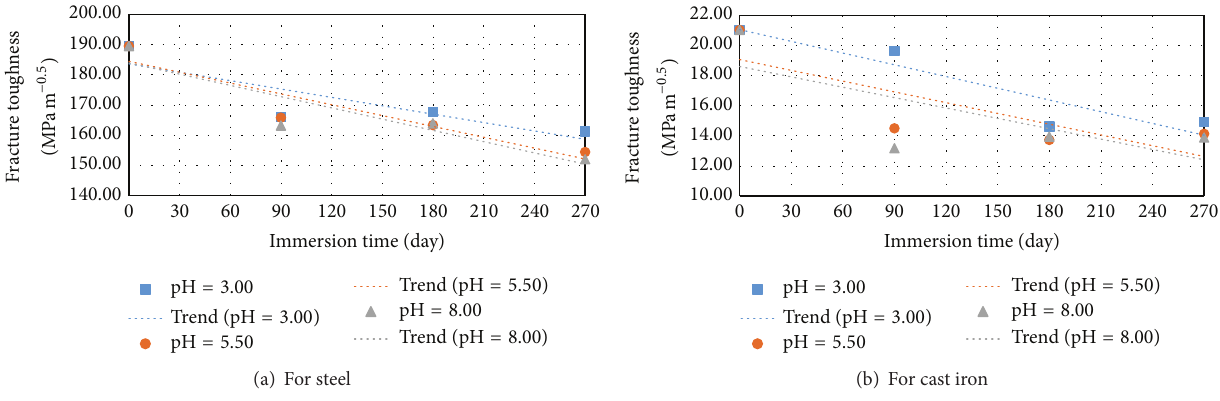
Figure 10: Fracture toughness reduction of specimen.